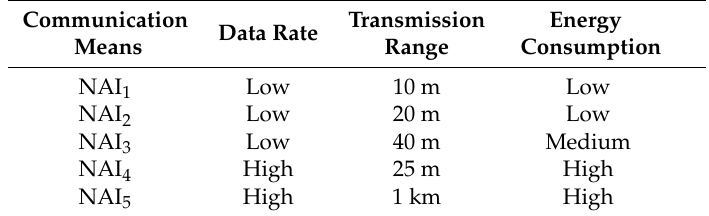
Table 6. Normalised Feature Values for Different Communication Interfaces.